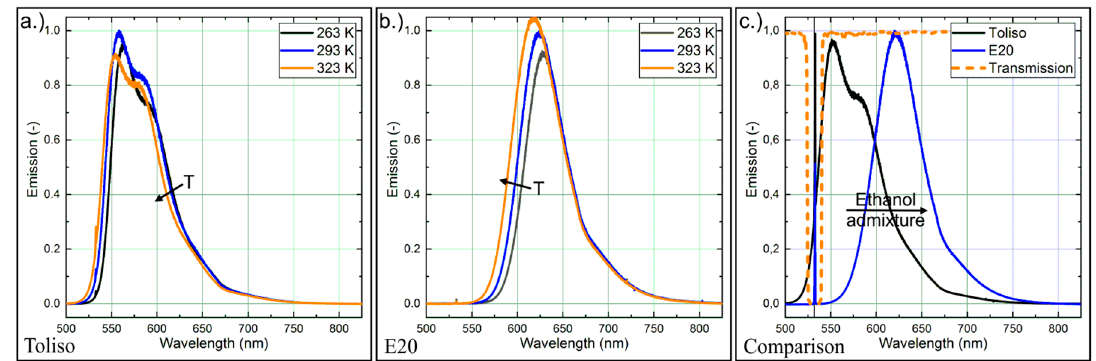
Figure 2. Fluorescence spectra for nile red (9.38 mg/l) in Toliso ( a ), E20 ( b ) at various temperatures normalized to 293 K, and a comparison of the two fuel mixtures plotted with the respective filter transmission curve ( c ). Fluorescence spectra were extracted from Reference [28].